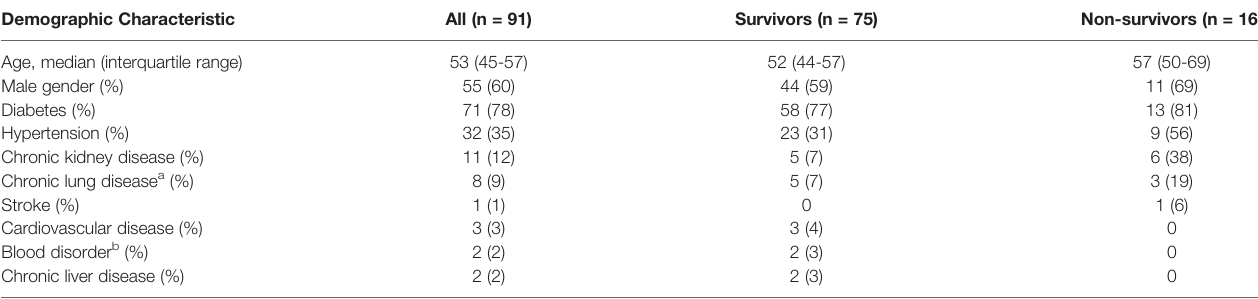
TABLE 1 | Demographic characteristics of individuals with